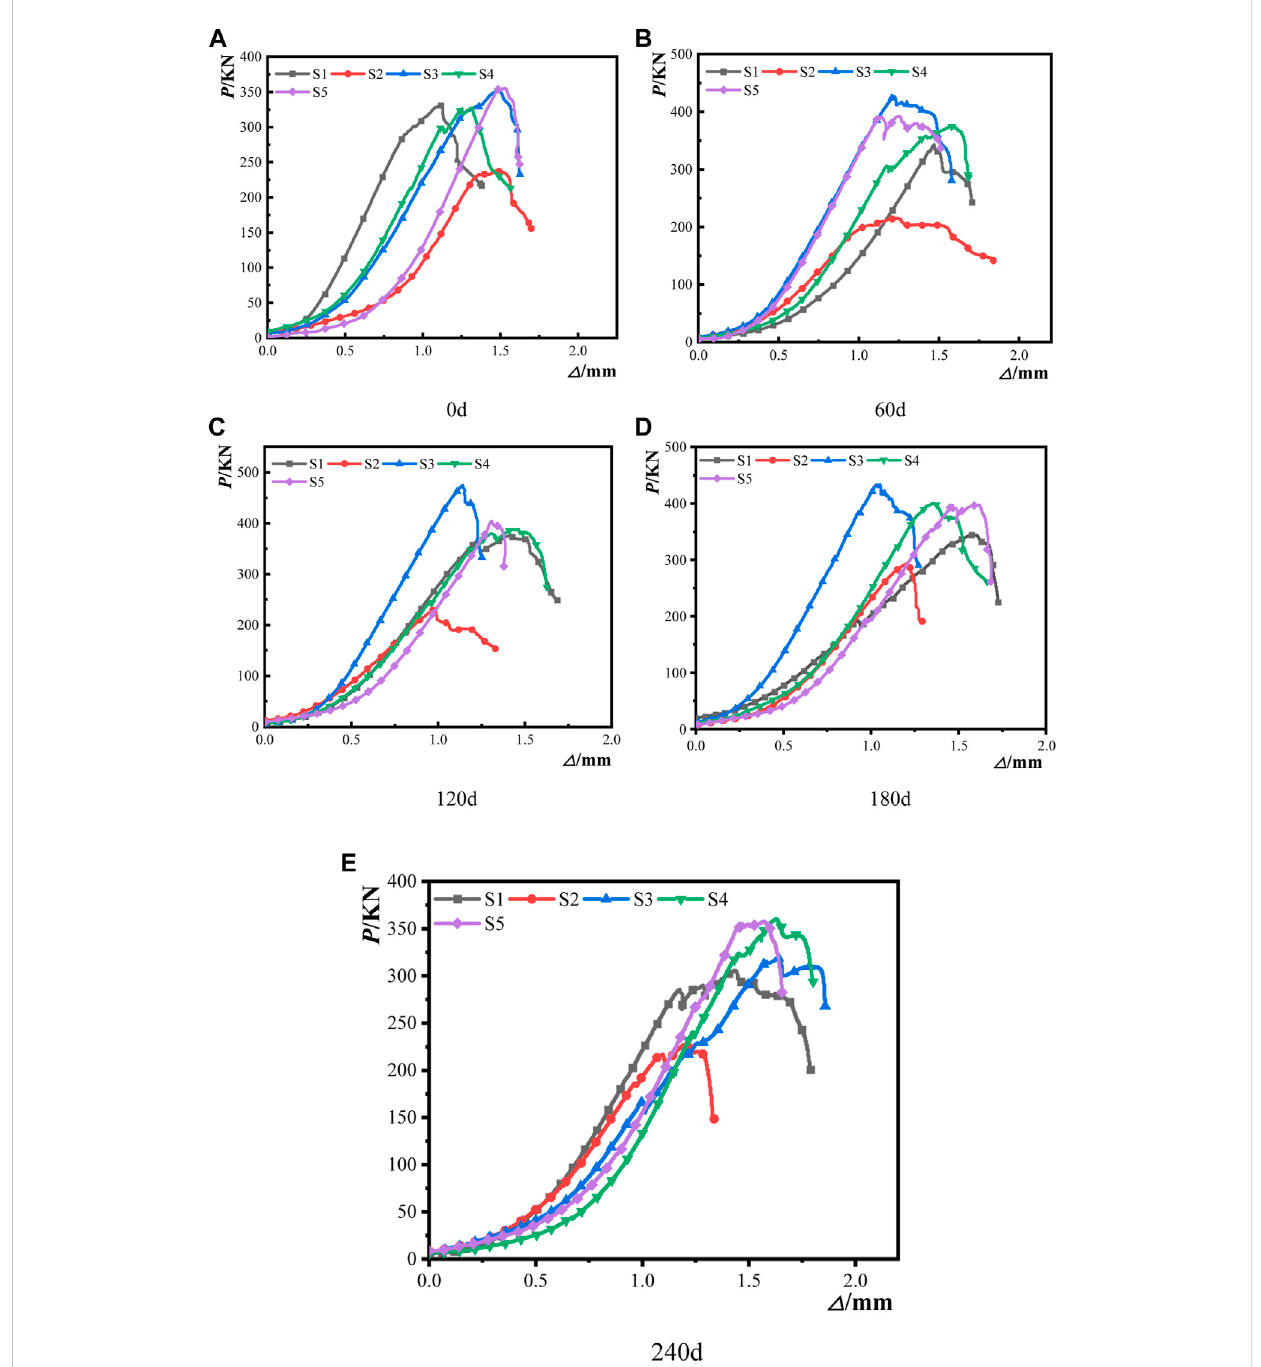
FIGURE 9 Load-settlement curve. (A) The load-settlement curve of S1 specimen. (B) The load-settlement curve of S2 specimens. (C) The load-settlement curve of S3 specimens. (D) The load-settlement curve of S4 specimens. (E) The load-settlement curve of S5